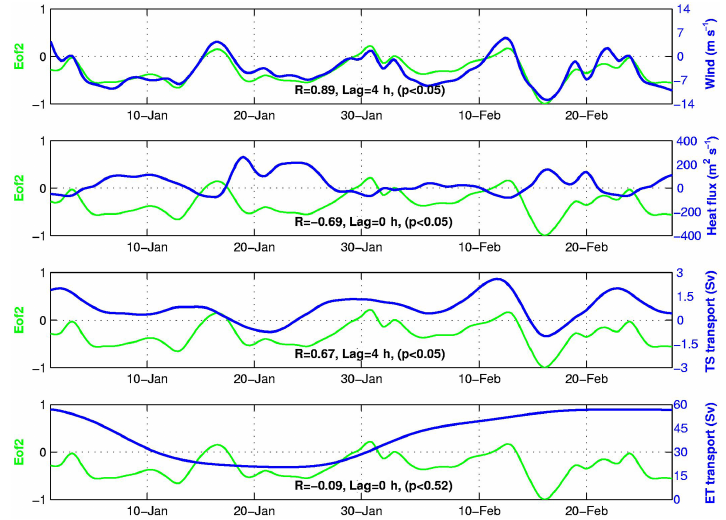
Figure 11. Temporal variation of EOF2, north–south component of wind speed, surface net heat flux, and TSC flux across the TWS section, and Kuroshio flux across the ET section. Their linear correlation coefficients and time lags are also indicated in each panel.